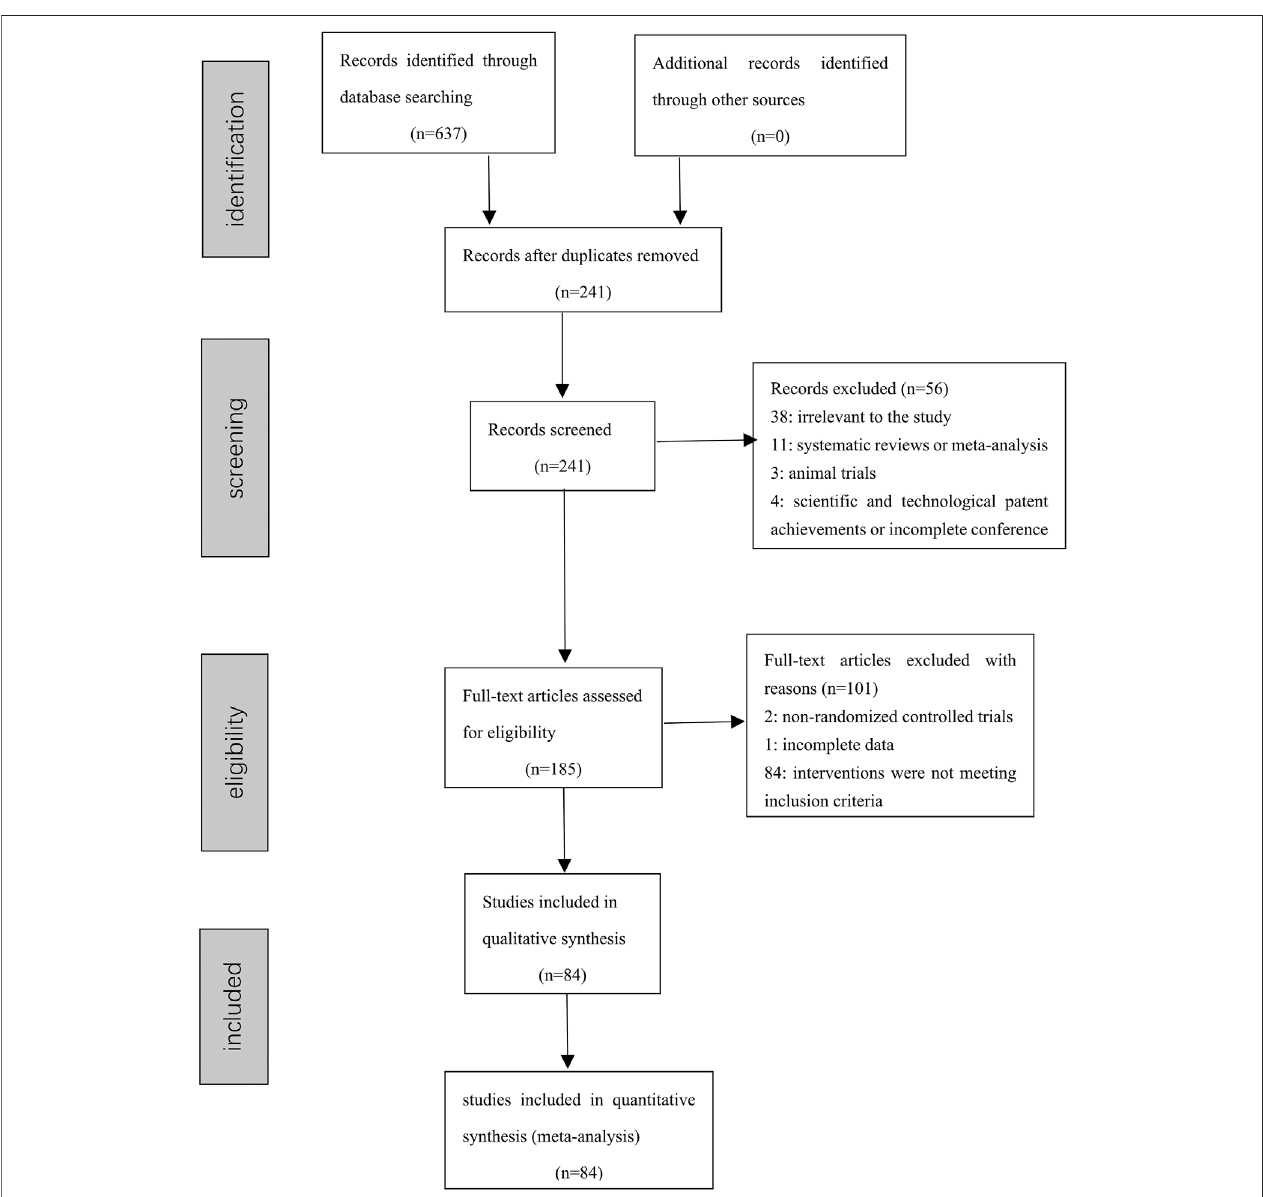
FIGURE 1 | Prisma fl ow